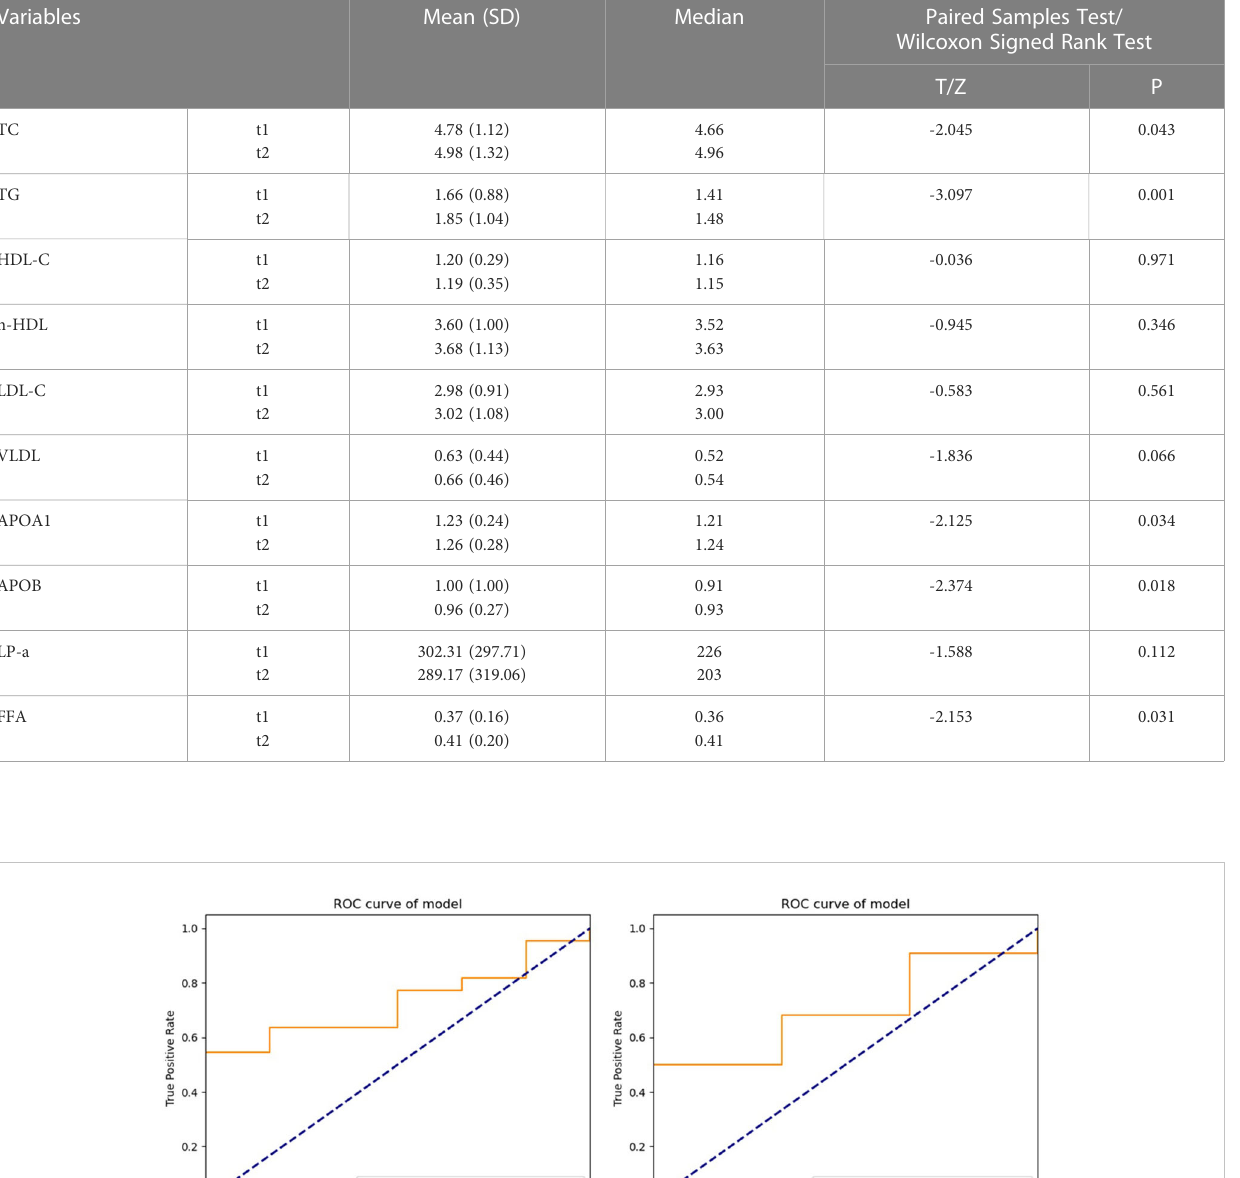
TABLE 2 The relation between changes to serum lipid level variables.